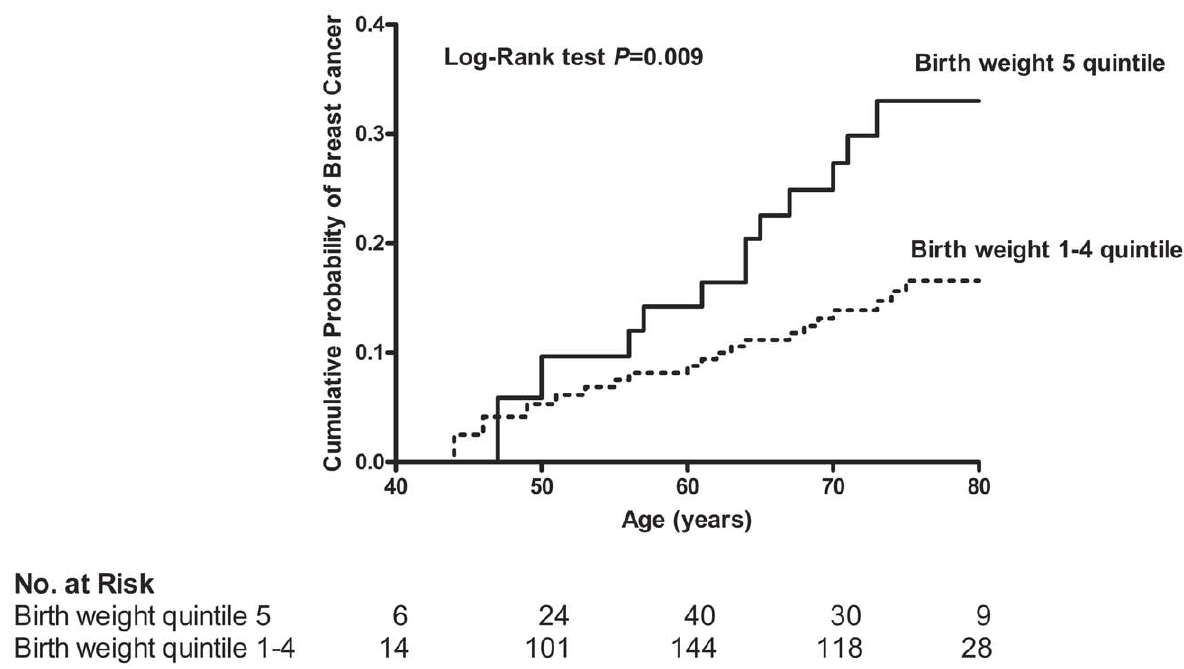
Figure 1. Kaplan–Meier Curves of the Cumulative Probability of Breast Cancer According to Infant Birth Weight Quintile.